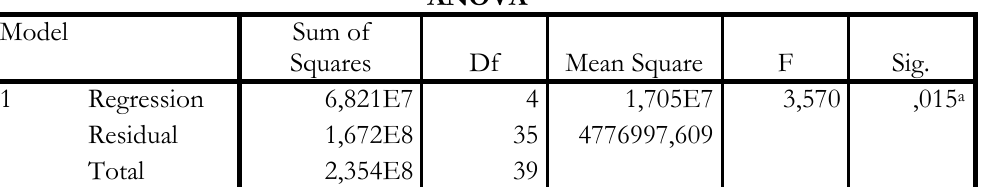
Table 2. Simultaneous Test Results (F-Test)